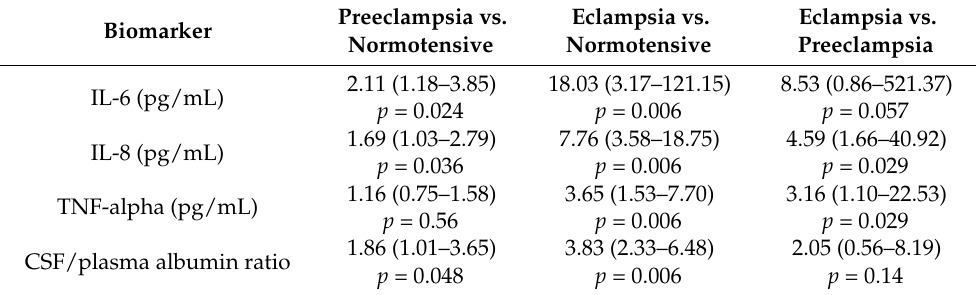
Figure 2. Log-transformed concentrations of neuroinflammatory markers and albumin quotient in CSF samples. Boxplot showing log-transformed CSF concentrations (IL-6, IL-8 and TNF-alpha) and log-transformed CSF/plasma albumin ratios as medians with interquartile ranges for IL-6 ( A ), IL-8 ( B ), TNF alpha ( C ) and albumin ( D ). Normotensive pregnancy ( n = 7), preeclampsia ( n = 4) and eclampsia ( n = 4). IL-6, interleukin 6; IL-8, interleukin 8; TNF-alpha, tumor necrosis factor alpha. Table 3. Fold changes of cerebrospinal fluid concentrations of cerebral biomarkers, neuroinflamma- tory markers and CSF/plasma albumin